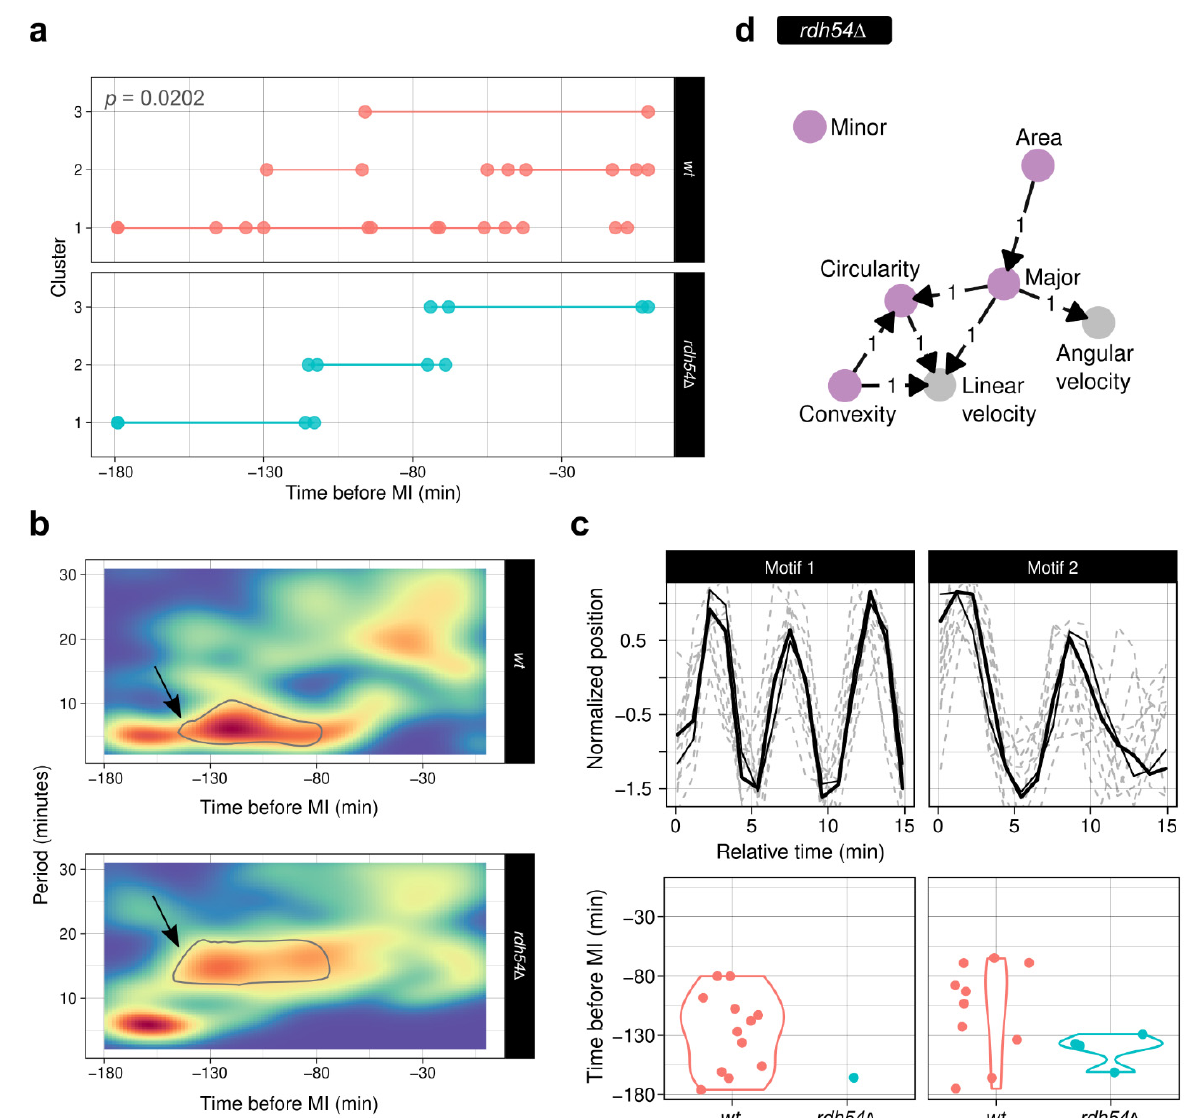
Figure 7. ChroMo analysis of CM in the rdh54 ∆ mutant reveals difference in the oscillatory movement. Analogously to Figure 6, ( a ) segment-plots for the unsupervised segmentation of velocity descriptors across both datasets. Top left, reported p -value for the ANOVA after LR between wt and rdh54 ∆ . ( b ) Global, non clusterised, heatmap-spectrograms of position data for the wt and the rdh54 ∆ mutant. Black arrows and outlines inside the plot show the time range at which the oscillatory period changes between both strains. ( c ) Top-2 discovered motifs within a time-window of 15 min, and the corresponding distributions of their duration, below. ( d ) DG for the causality relations found by the VLTE algorithm with a maximum lag of 10 and a presence threshold of 80%.